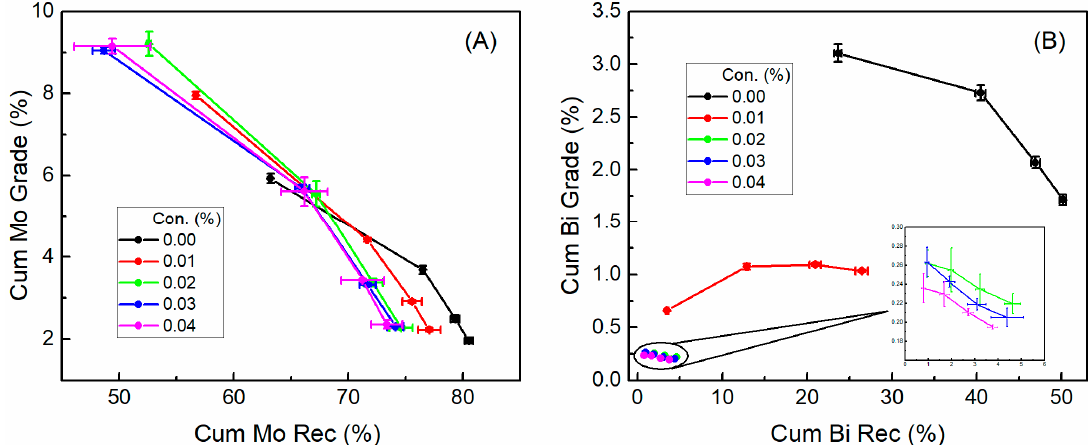
Figure 8. Cumulative grade versus recovery curves for different H 2 O 2 concentrations: ( A ) molybdenite, ( B ) bismuthinite. Error bars represent the standard deviation between duplicate tests.